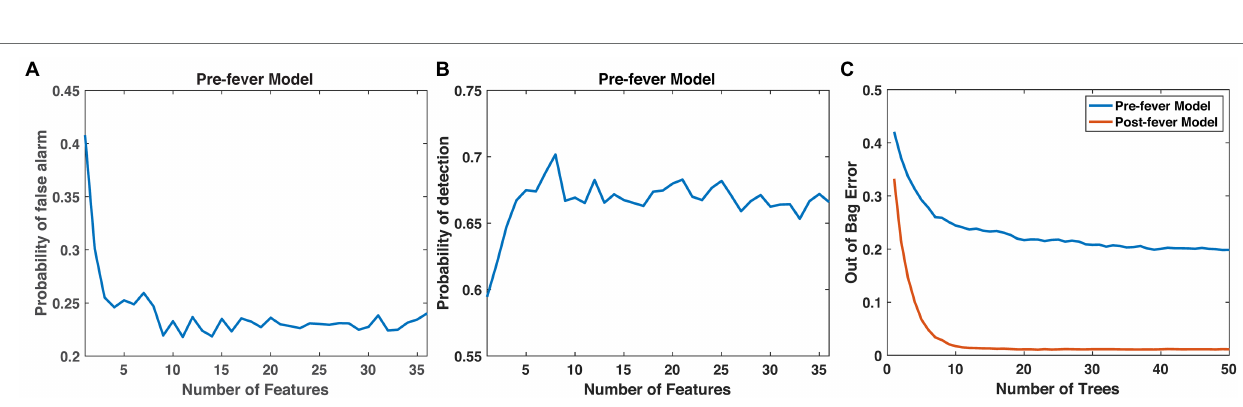
shown in Figure 7 for one representative subject for each